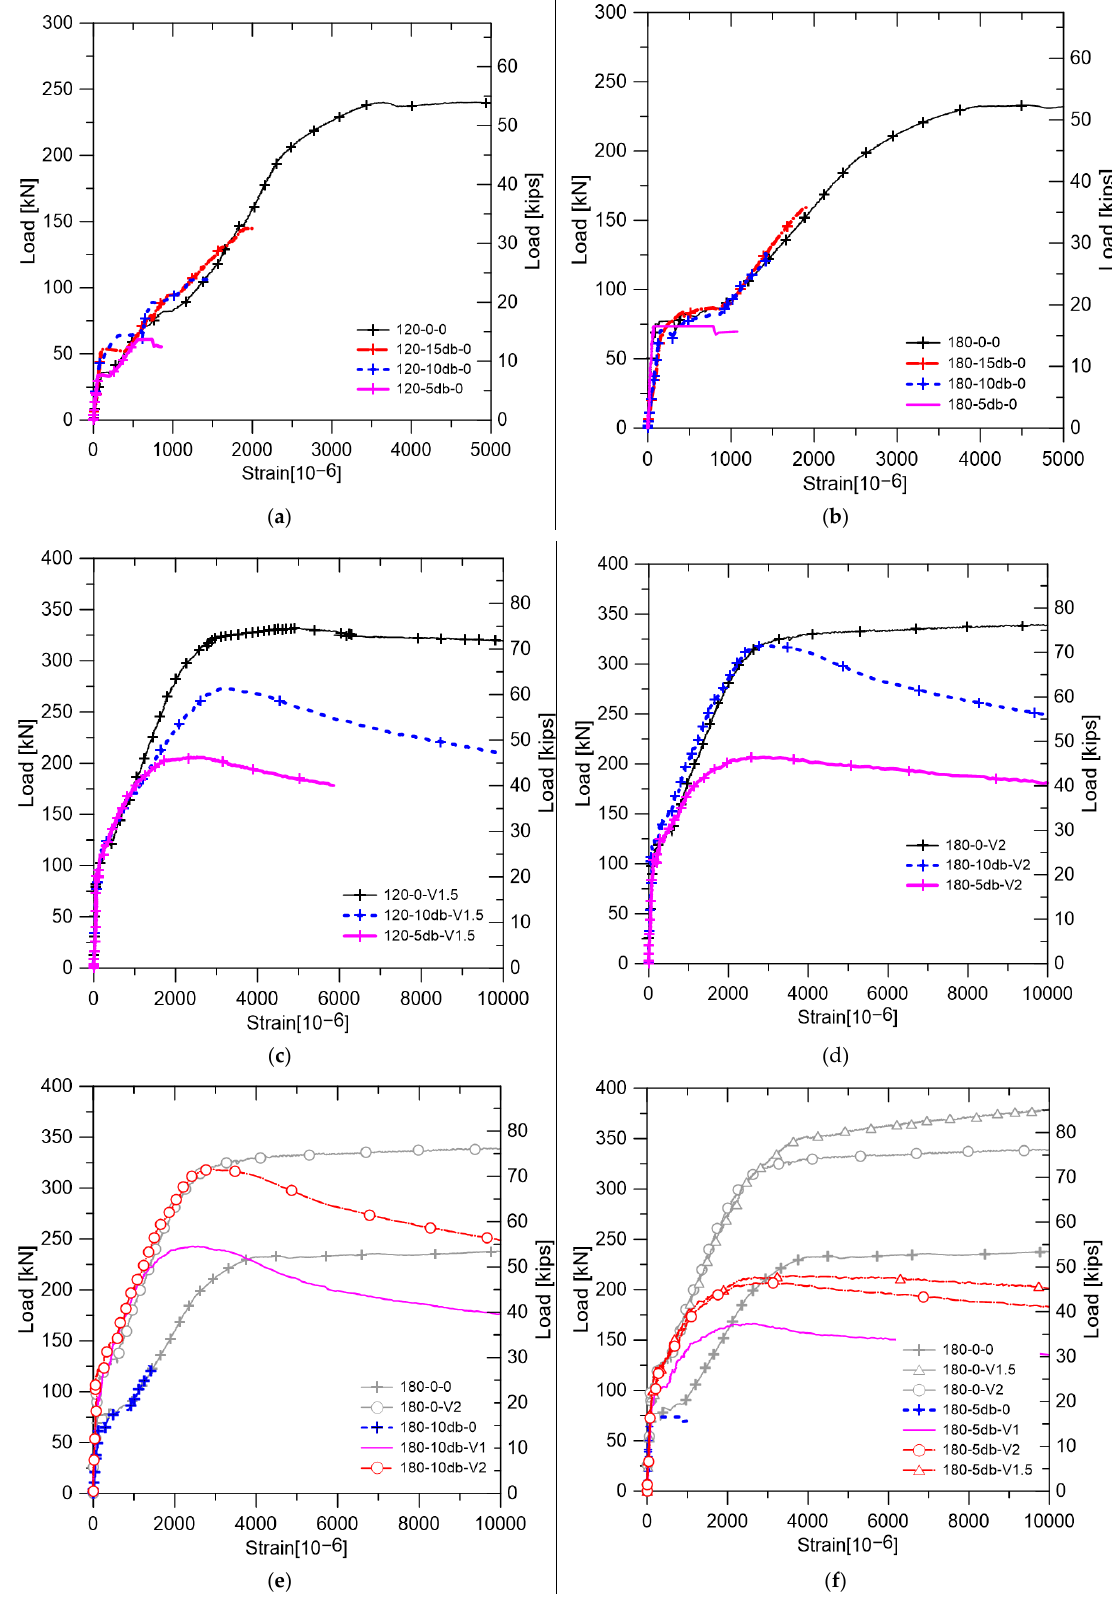
Figure 9. Strain at steel reinforcement location: ( a ) Specimens with 120-0 matrix; ( b ) Specimens with 180-0 matrix; ( c ) Specimens with 120-V1.5 matrix; ( d ) Specimens with 180-V2.0 matrix; ( e ) Specimens with 10 db lap length; ( f ) Specimens with 5 db lap length effect of steel fiber. Table 5. Stress at lap-spliced region measured and calculated values.